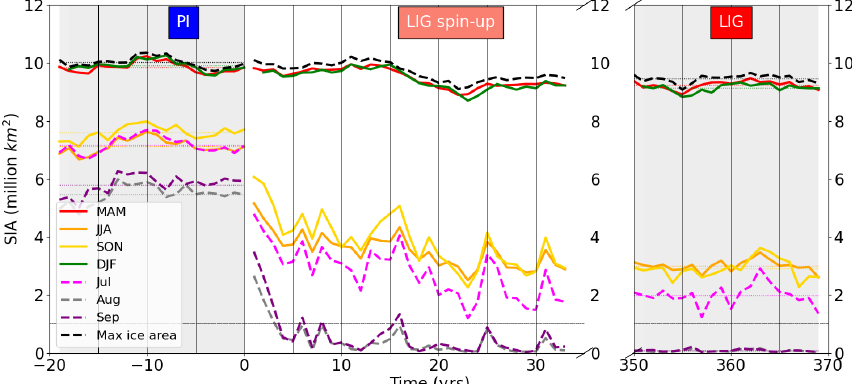
Figure 4. The loss of Arctic sea-ice during the LIG spin-up. Comparison of seasonal Arctic sea-ice area (SIA) between simulated LIG and PI and first 35 years of LIG spin-up period, over the region 70–90 ◦ N, computed from monthly model output using ice-covered grid cells only. The black dashed line corresponds to maximum SIA reached any month during the year. A new ice-free state in August and September was reached within the first 5 years of the LIG spin-up.